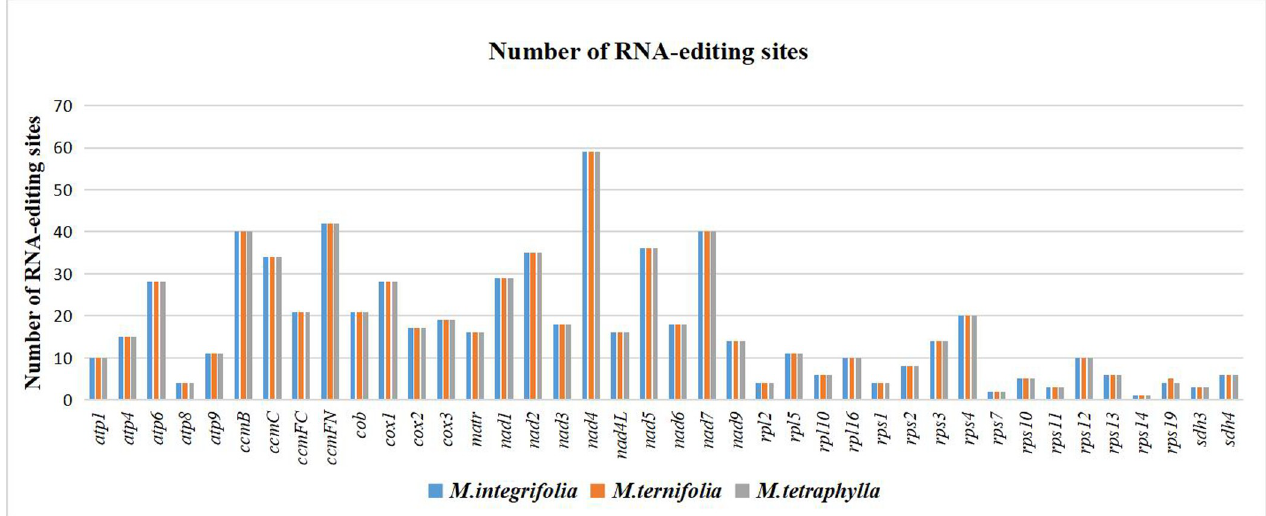
Fig 4. The distribution of RNA-editing sites in the mt protein-coding genes of three species of Macadamia . The bars of different colors represent the number of RNA-editing sites of each gene.